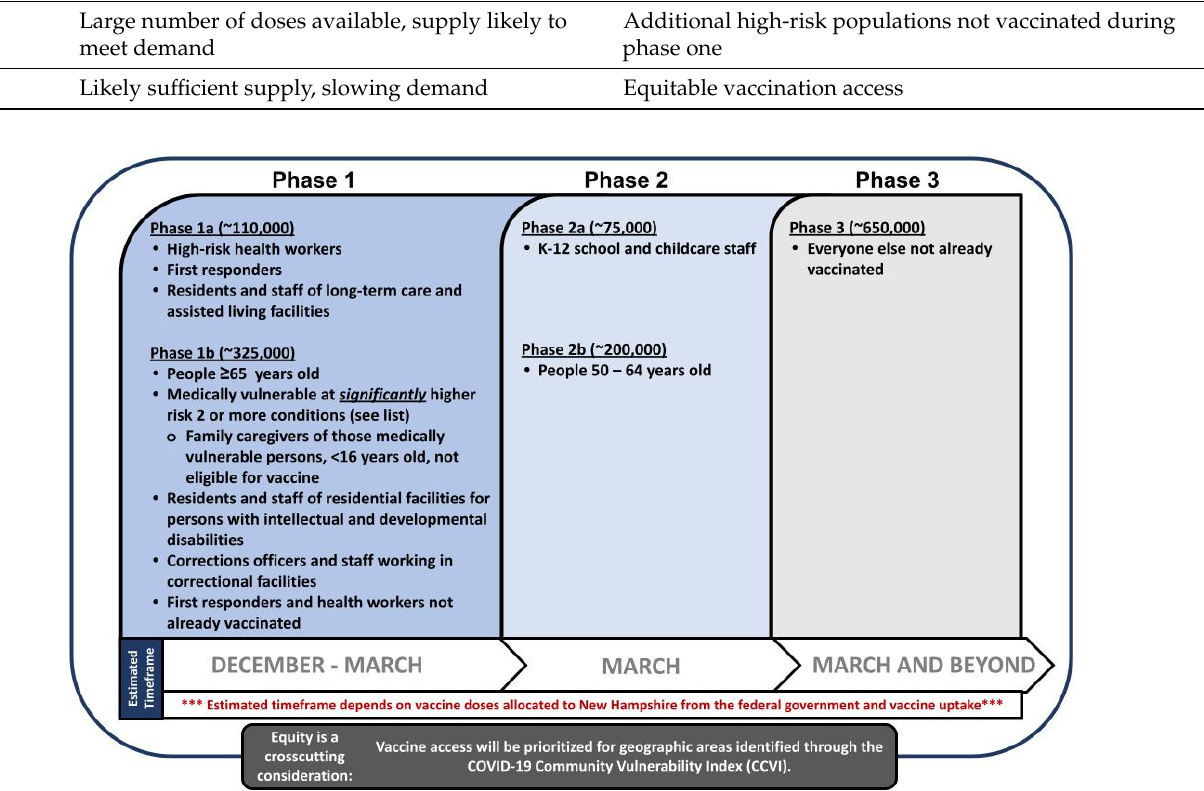
Figure 2. Final NH Vaccine Allocation Plan (25 March 2021) [8,9]. The plan included three phases with a crosscutting 10% Vaccine Equity Allocation beginning in Phase 1b as represented by the dark gray bar.